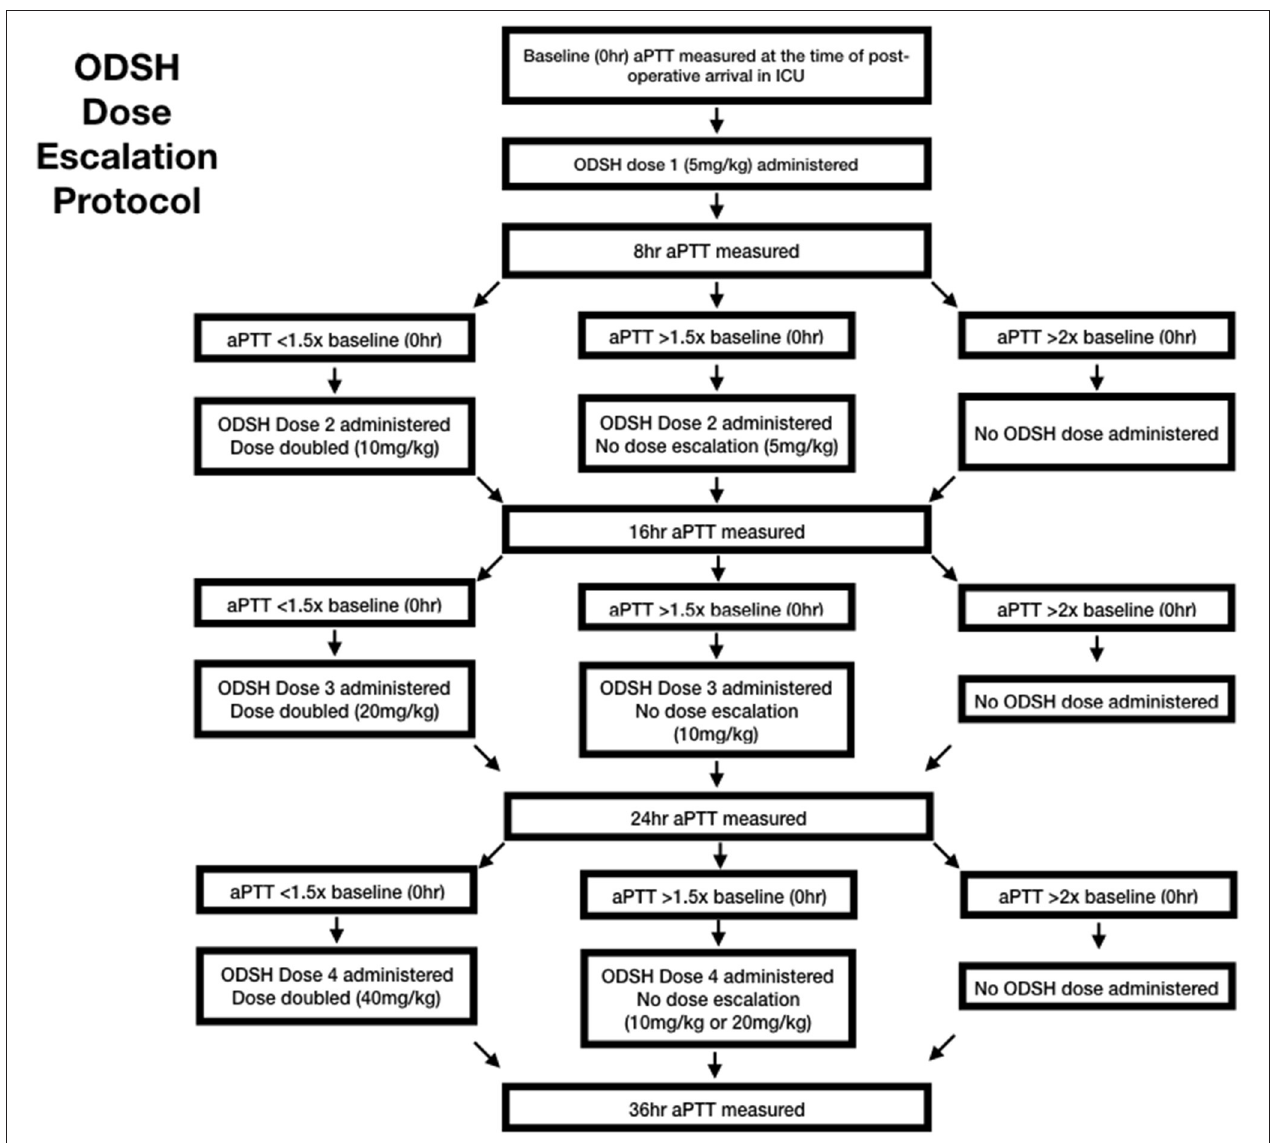
FIGURE 1 | ODSH dose escalation protocol.